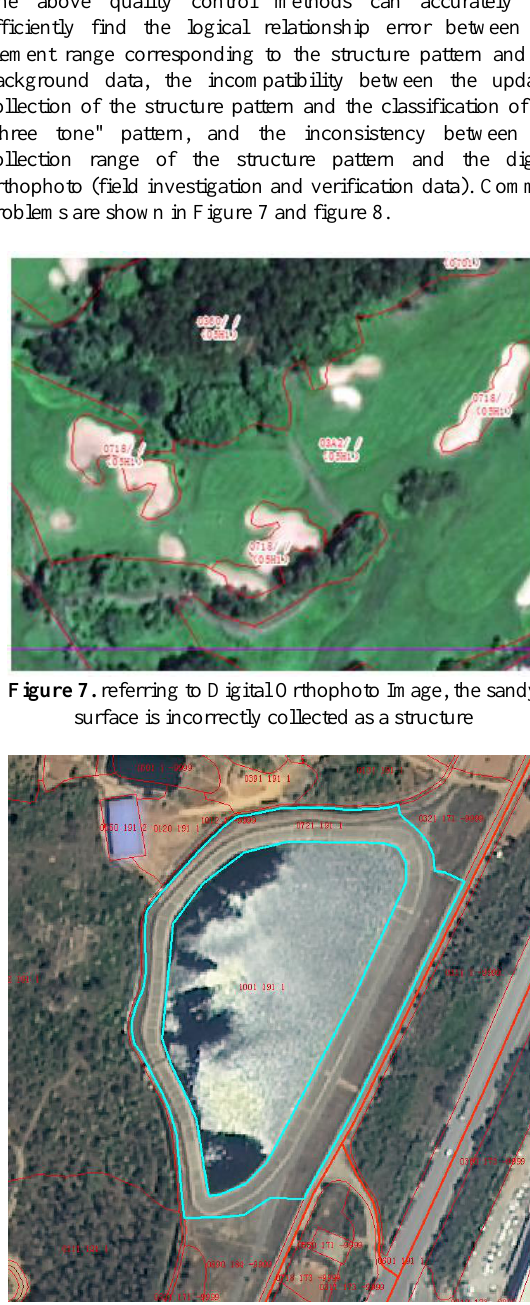
Figure 8. inconsistency between structural spots and background